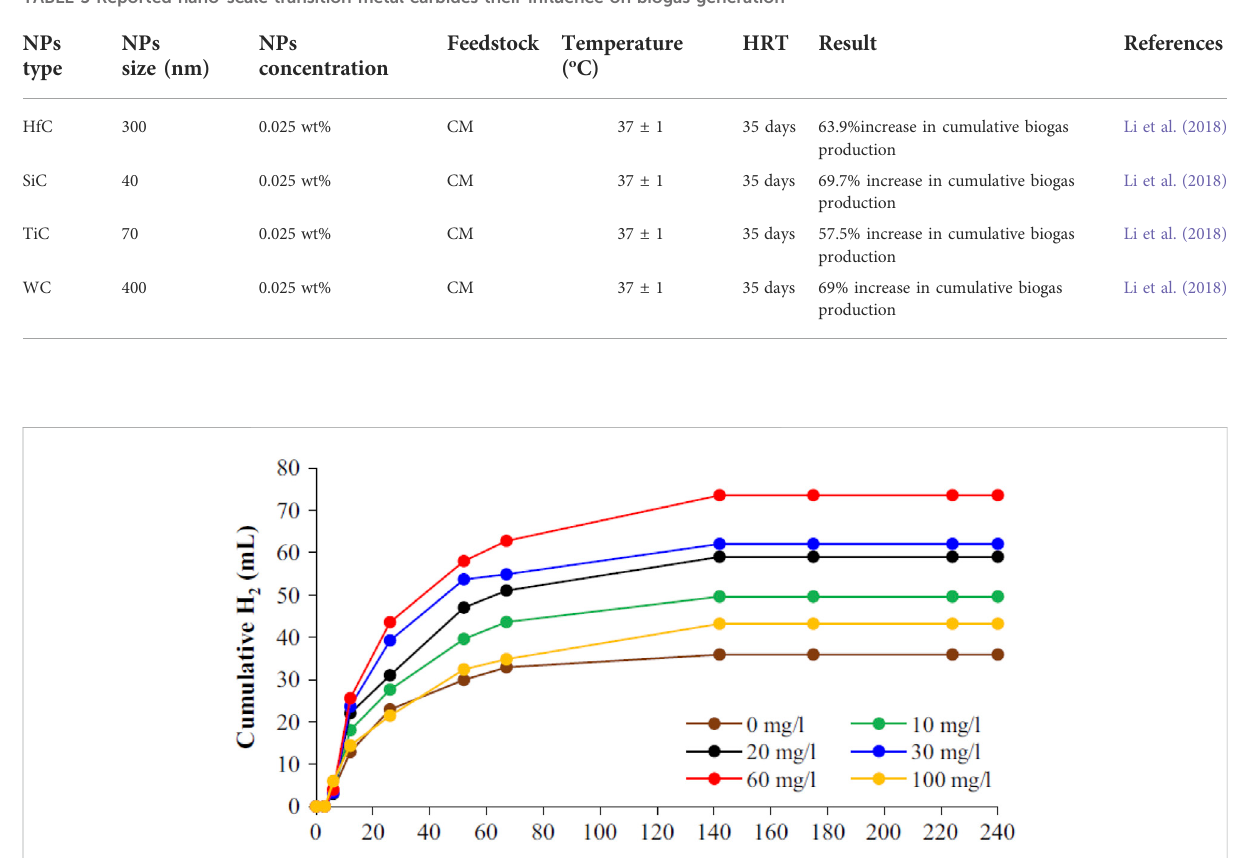
TABLE 5 Reported nano-scale transition metal carbides their in fl uence on biogas generation